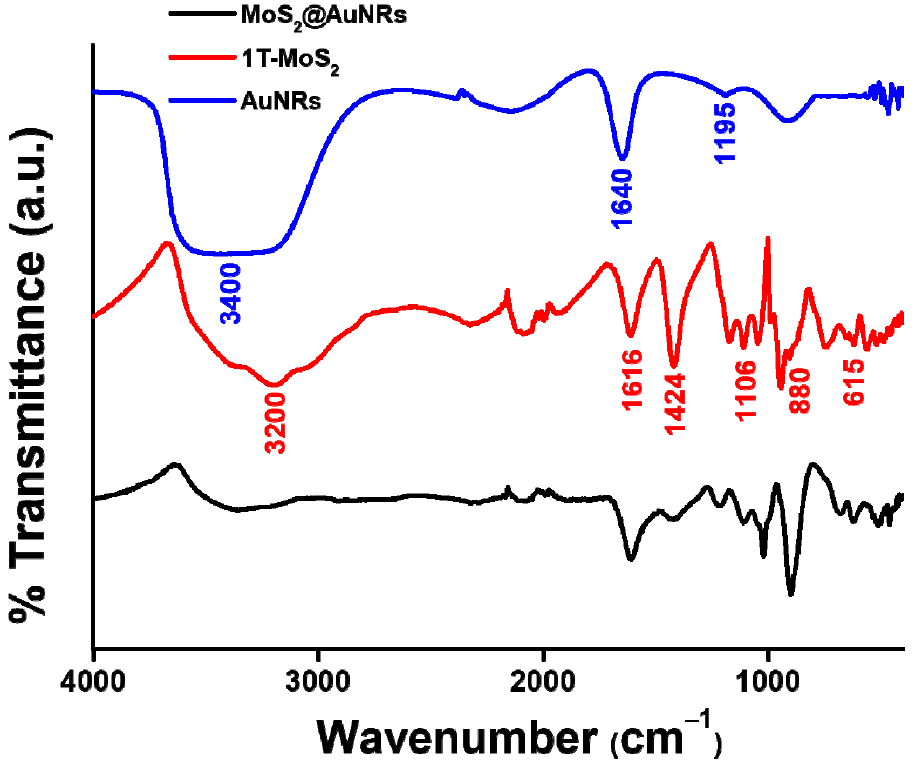
Figure 3. FTIR spectra of gold nanorods (AuNRs), metallic molybdenum disulfide (1T-MoS 2 ) nanosheets (NSs), and MoS 2 @AuNRs.